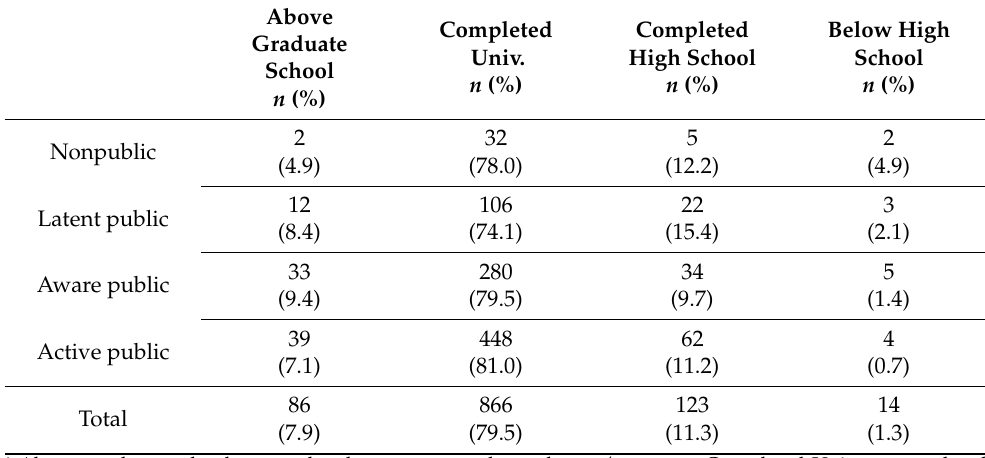
Table 5. Four types of publics and education in China